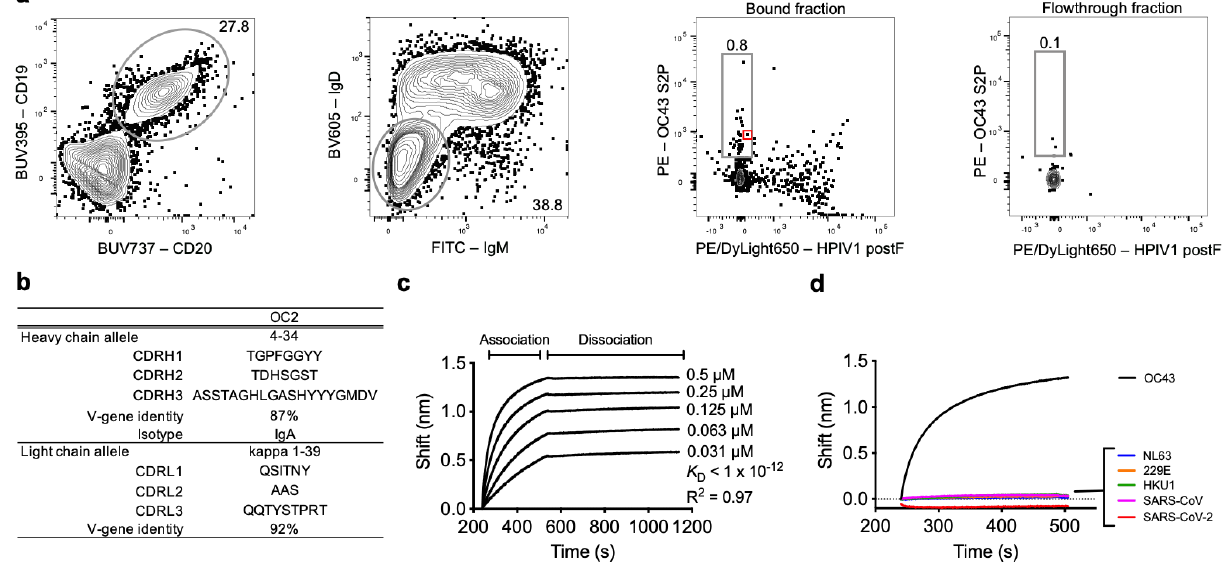
Figure 2. Identification of an OC43 neutralizing B cell by flow cytometry. Spleen from an adult donor was enriched for cells that could bind to OC43 S2P. ( a ) The gating strategy to isolate live, IgD − /IgM − , OC43 S2P-binding B cells is shown. Numbers indicate the percentage in the gate of total cells shown in the plot. The immunoglobulin genes were sequenced and cloned from the B cell indicated by the red square to produce the neutralizing mAb OC2. ( b ) Allele usage, CDR sequences, and isotype of OC2. ( c ) Binding kinetics of OC2 with OC43 S2P, ranging from 0.5 µM to 0.031 µM. ( d ) Binding during the association phase of OC2 with 0.5 µM of OC43 S2P, SARS-CoV-2 S2P, and HKU1 and spike from NL63, 229E, and SARS-CoV. ( c , d ) BLI data shown is background subtracted using a negative isotype control mAb. K D represents the apparent binding affinity measured by biolayer interferometry. R 2 represents the coefficient of determination.